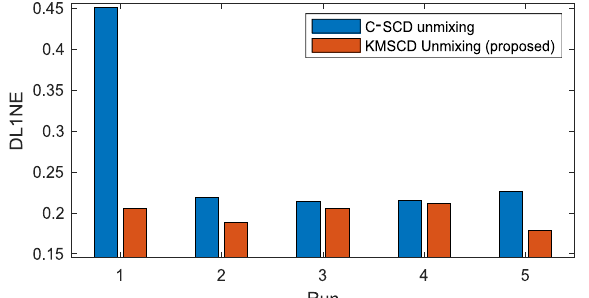
Figure 5. Plots the mean of the differential L1 norm (DL1NE) of the 5 repeated runs of the Selene Dual scene reconstruction performed by the C-SCD and the proposed KMSCD DL learning algorithms. The STD of the DL1NE processed by the C-SCD is almost double of that processed by the proposed method over the 5 experimental runs, further demonstrating the superior performance of the proposed KMSCD